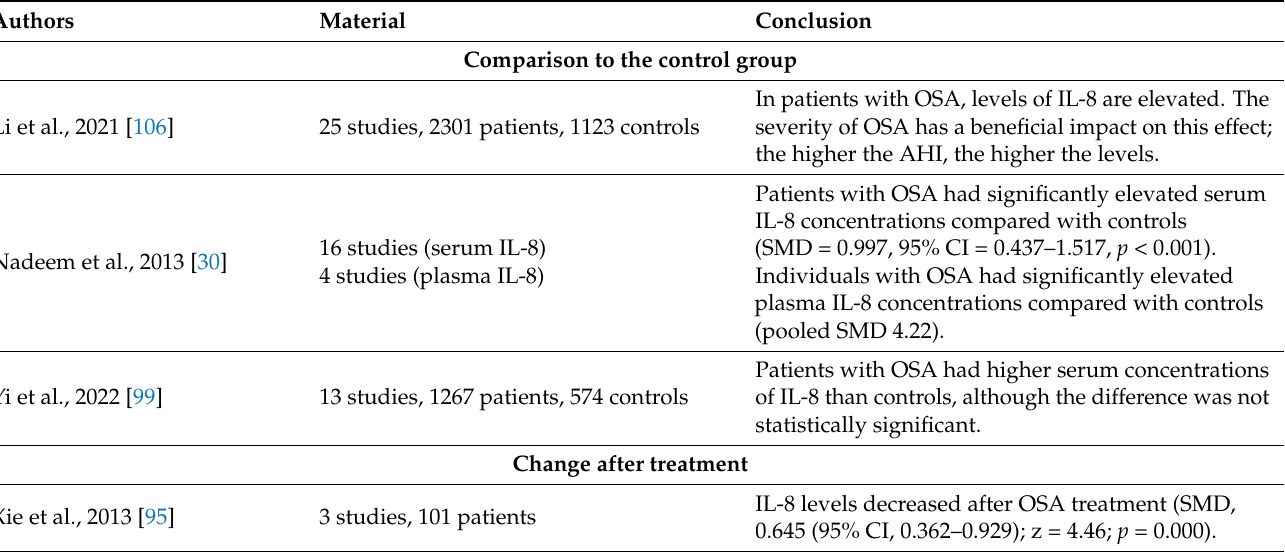
Table 6. Meta-analyses of IL-8 studies in OSA